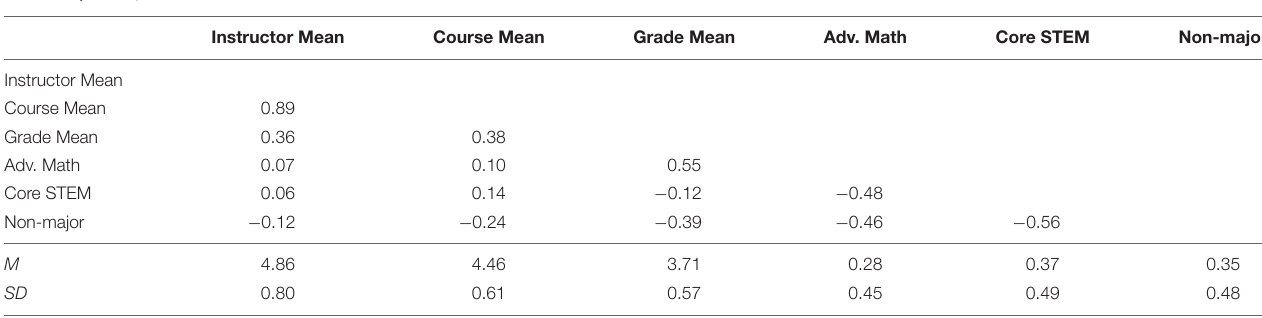
TABLE 4 | Descriptive statistics and intercorrelations for class-level